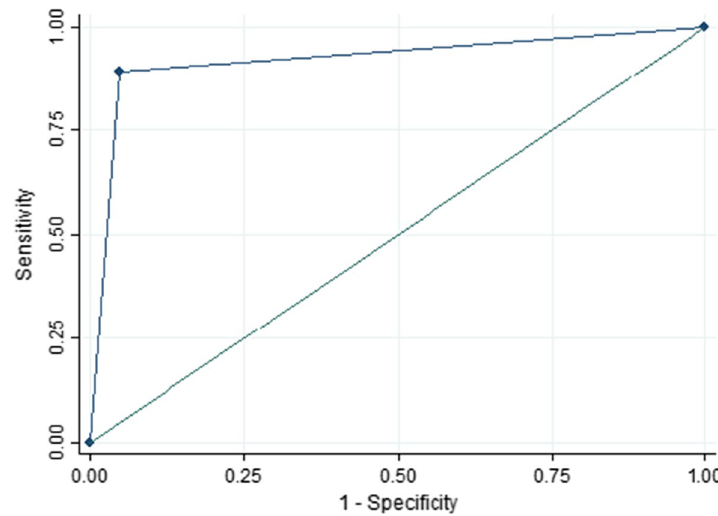
Fig. 5 Pulmonary embolism ROC curve in the test set